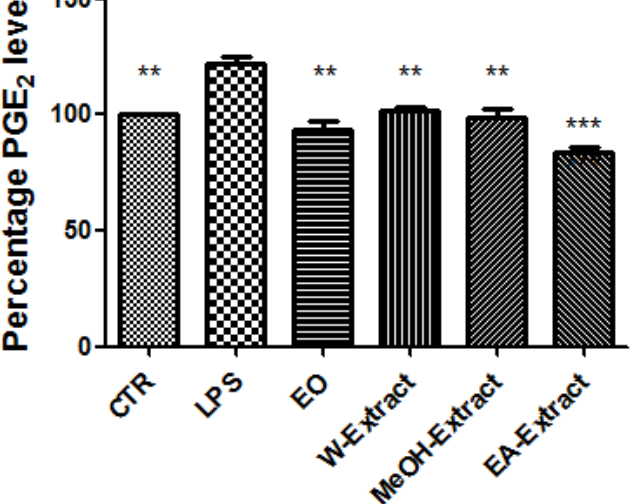
Figure 2. E ff ect of essential oil (EO) and water (W), methanol (MeOH) and ethyl acetate (EA) A. santonicum extracts (100 µ g / mL) on LPS-induced PGE 2 level in rat colon specimens. All extracts and EO were able to restore the level of PGE 2 observed in control (CTR) group. p < 0.0001; post-hoc, ** p < 0.01, *** p < 0.001 vs. LPS.